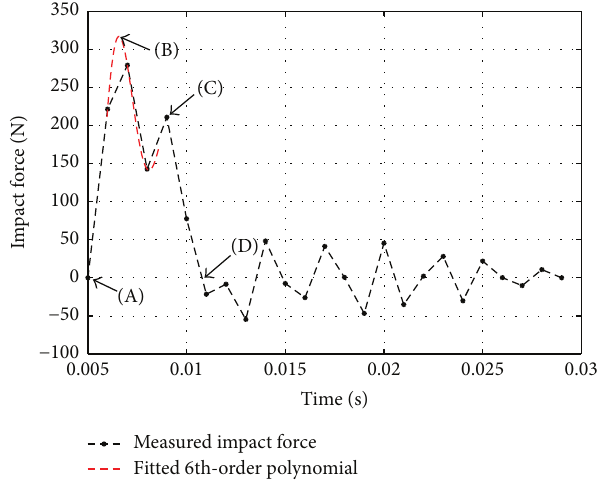
Figure 1: A typical experimentally measured time history of the impact force and the corresponding fitted 6th-order polynomial. The points in time representing the start of the impact (A), the maximum deformation (B), the secondary peak (C), and the end of restitution phase (D) are shown on the figure.